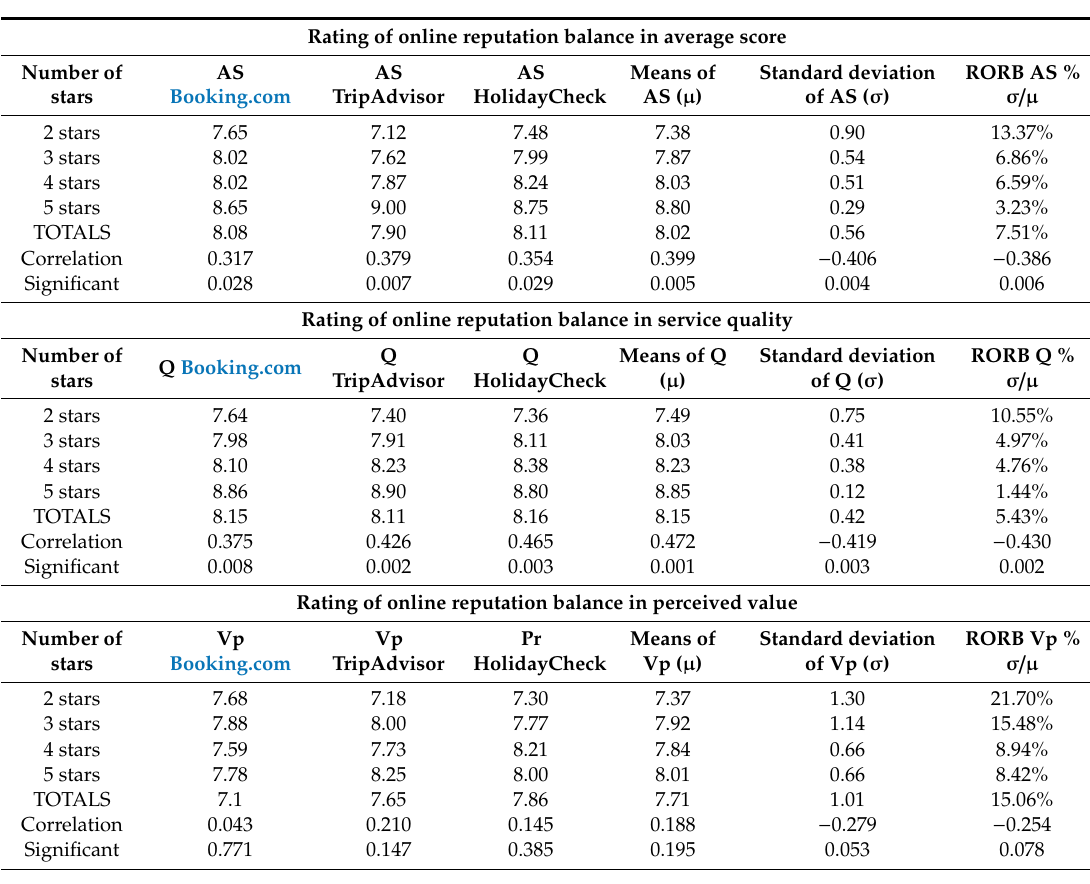
Table 2. Rating of online reputation balance in the South of Tenerife